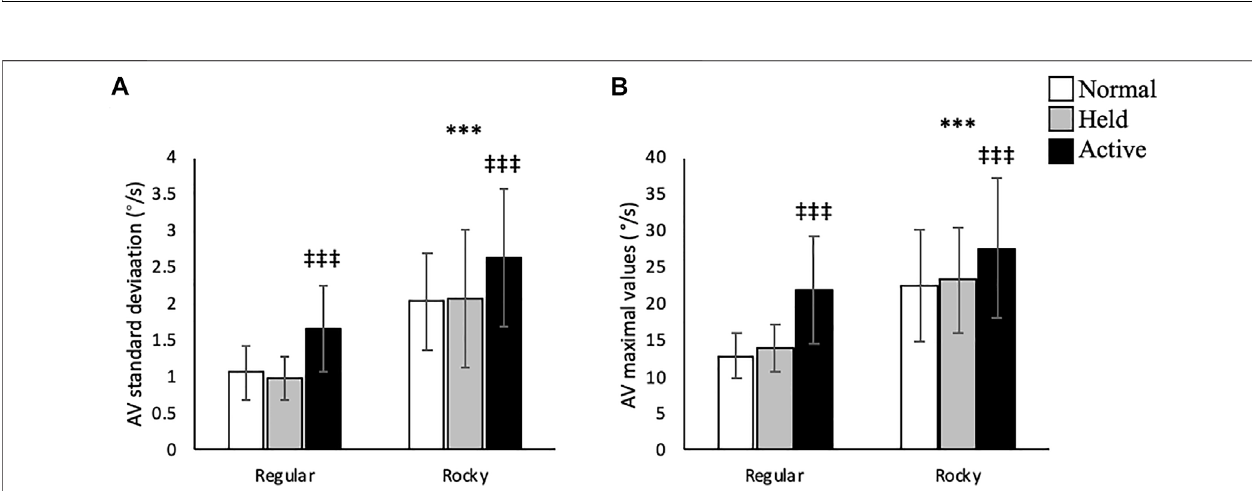
FIGURE 4 | Trunk linear velocity (A) standard deviation (m/s) and (B) maximal values (m/s) according to surface type for each arm condition in the anteroposterior axis.***showsthatrockysurfaceledtolargervaluesthan regularsurfaceat p < 0.001,while ‡‡‡ showsthatactive armswingledtolargervaluesthan normaland heldat p <